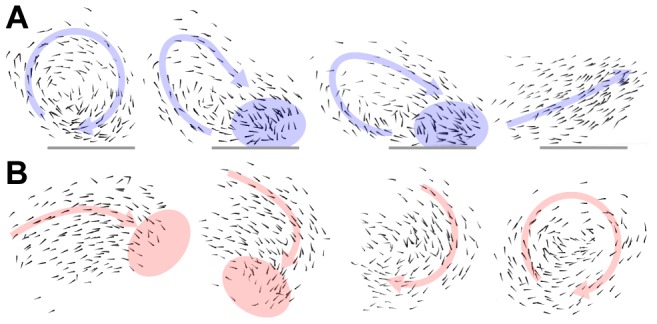
Time-lapse examples demonstrating transition mechanisms.(A) Transition initiated by interaction with the tank wall. In the first picture, the fish is in a milling state, indicated by the blue arrow, and the lower part of the group is close to the tank wall (grey line). In the second picture, the interaction with the wall has caused a local increase in density, marked by the blue region, and a few individuals have started to turn opposite the milling direction. This cascades, and in the third picture the flow of the mill is interrupted as a large proportion is breaking away from the milling direction. The result is total unraveling of the milling state and transition into the polar state, seen in the last picture. (B) Transition from the polar state to the milling state, initiated by individuals in the shoal. In the first picture, the group is in a polar state, signified by the red arrow. A few individuals in the front, visible in the red region, have started to turn downwards. This leads the group as a whole into a sharp right turn, and as picture two demonstrates, the group is forced into a shape with larger curvature. Now, when the individuals in front of the group can spot the back of the group, they continue the turning and start following the back, as seen in the third picture. In the final picture, as the front individuals catches up with the tail, the loop closes and the transition into the milling state is complete.